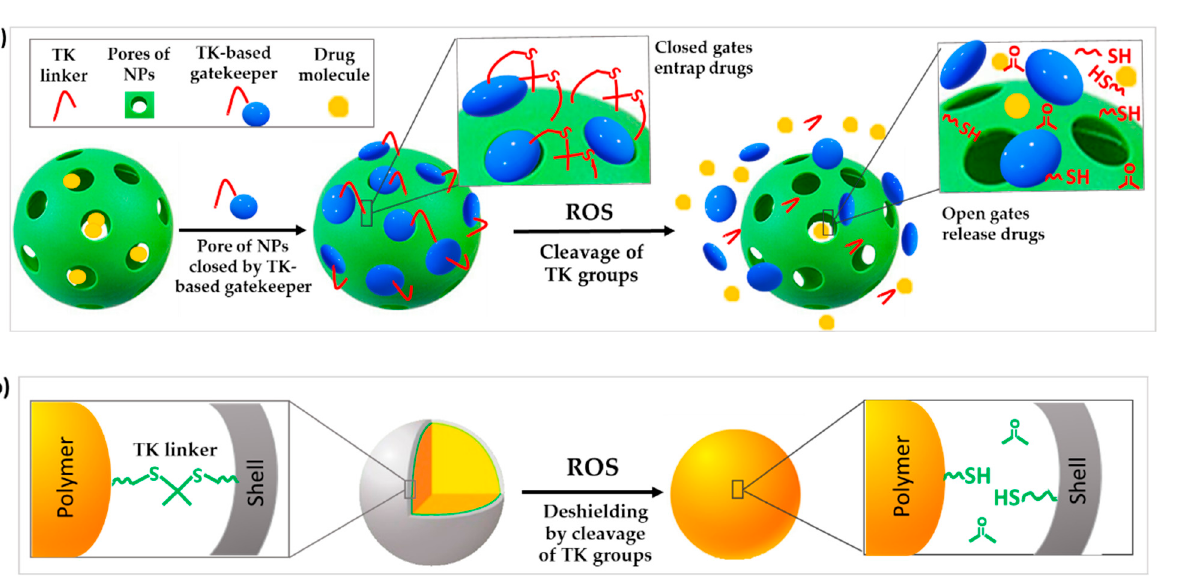
Figure 4. Schematic illustration of the chemical structure and corresponding release mechanisms of TK-based ROS-responsive nanosystems where TK is used to ( a ) create ROS-responsive drug-releasing gates or ( b ) induce the surface deshielding in response to ROS.